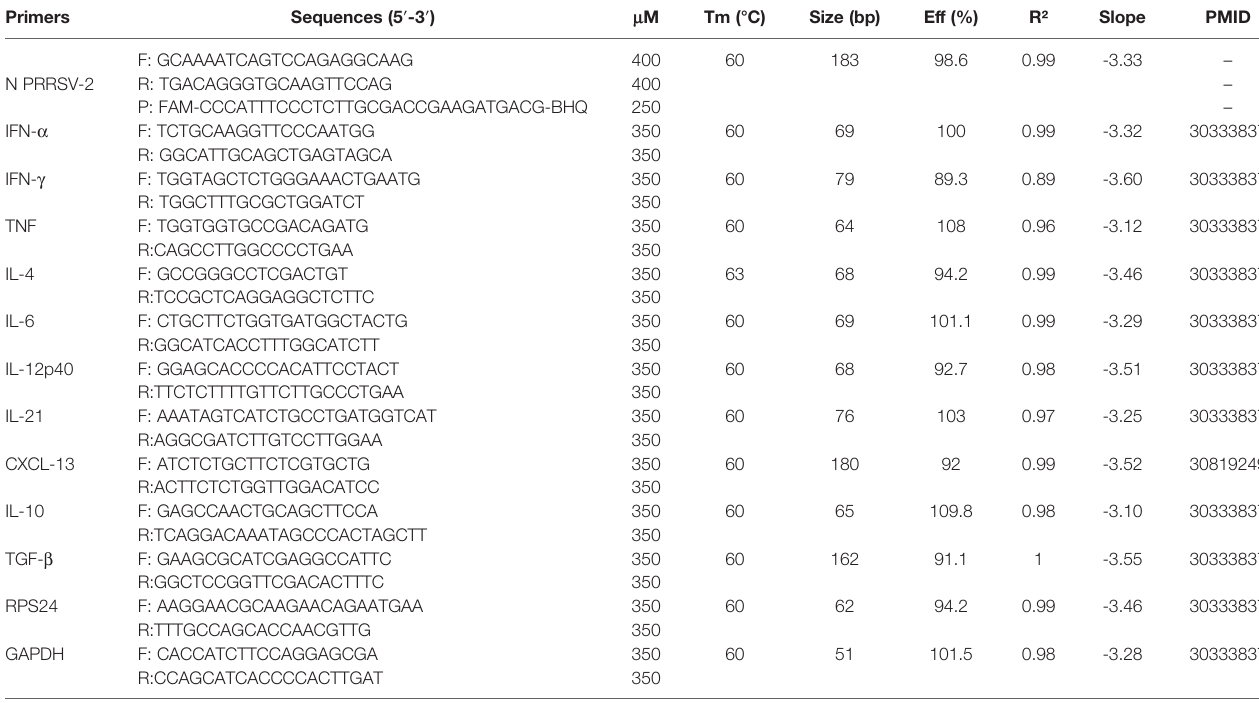
TABLE 1 | Primers used for